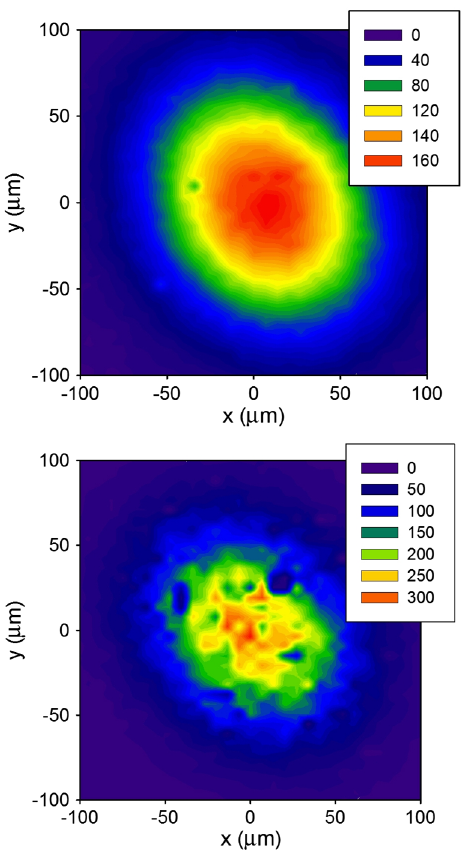
FIG. 9. Beam images obtained in the visible region by using the 400 nm BP filter (top) and in the EUV region by using the 1 . 3 μ m aluminum foil filter